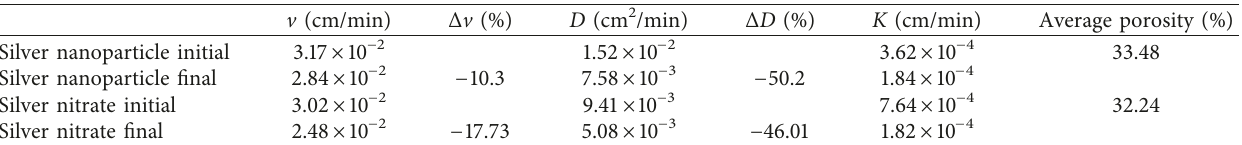
Table 1: Linear velocity, dispersion coefficient, and hydraulic conductivity for silver nanoparticle and silver nitrate filters before and after 2 weeks of constant flow of E. coli .